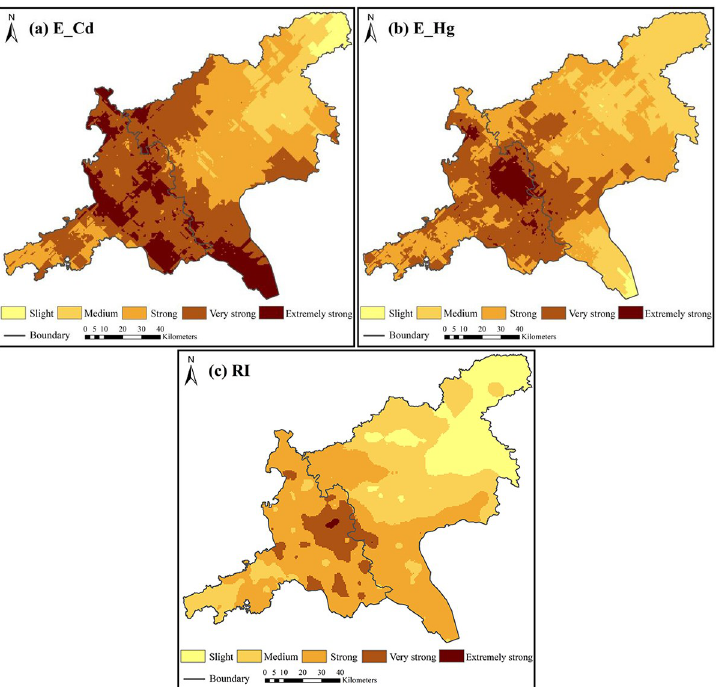
Fig 4. Spatial distribution of potential ecological risk of (a) E Cd , (b) E Hg , and (c) RI.